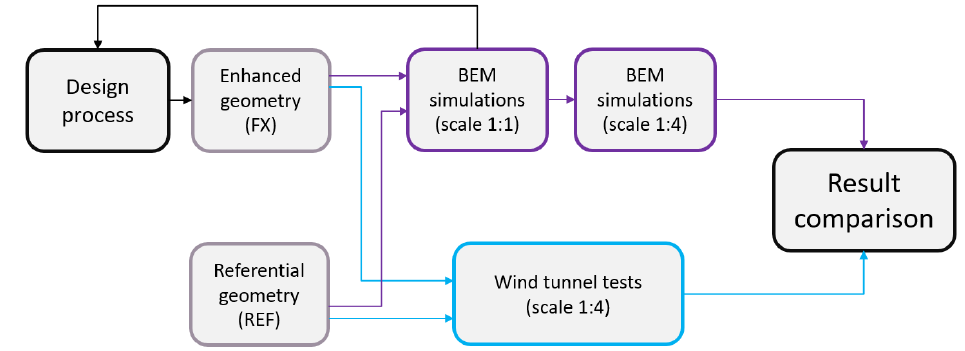
Figure 4. Procedure scheme of an iterative blade redesign and rotor analysis.